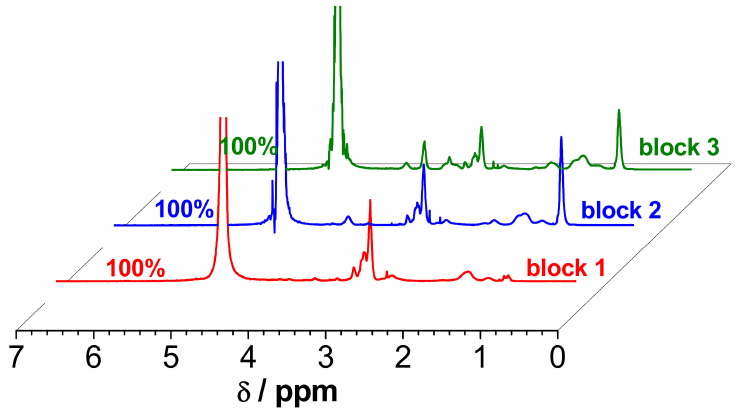
Figure 4. 1 H nuclear magnetic resonance (NMR) spectra (D 2 O) for triblock copolymers of DMA, NIPAM and HEAA and by iterative Cu(0)-mediated